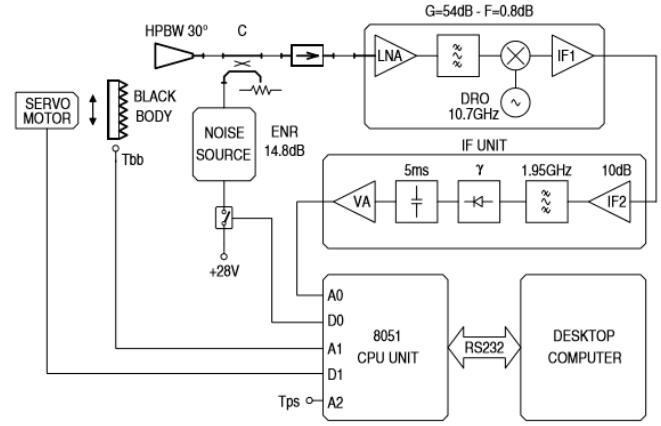
Figure 1. Block diagram of the microwave radiometer operating at the centre frequency of 12.65 GHz